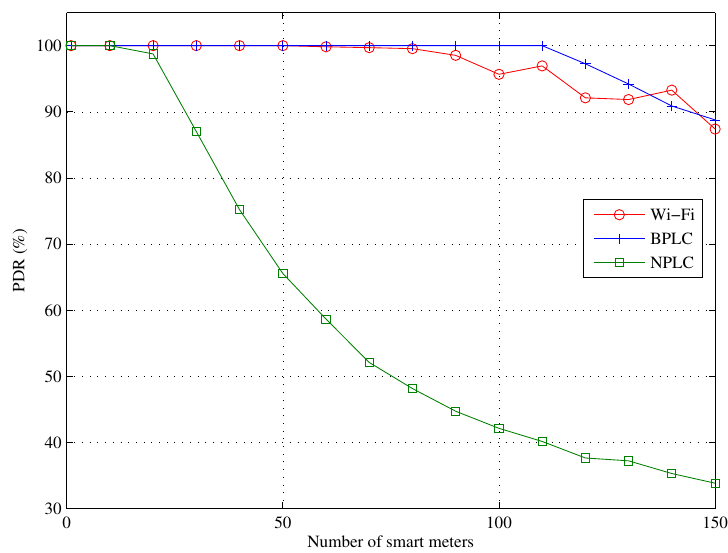
Figure 4. Packet delivery ratio as a function of network load in smart metering.